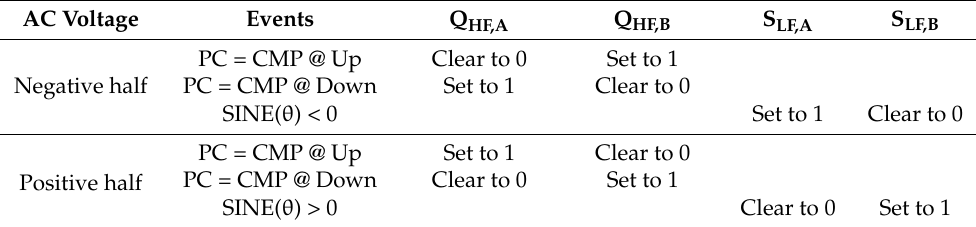
Table 1. Action qualifier setting for PC event for totem-pole